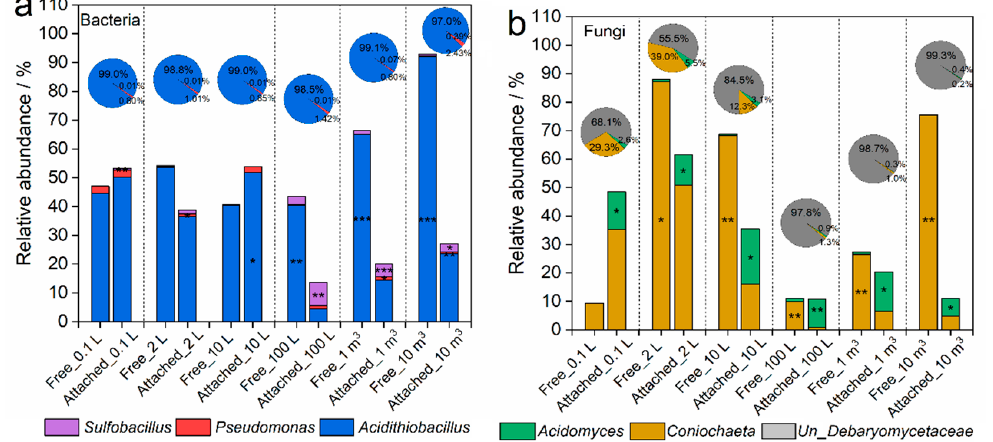
Figure 2. Relative abundance of dominant genera in free and attached microbial communities: ( a ) bacteria; ( b ) fungi. The pie charts represent the initial microbial community structures of mixotrophic acidophiles in different scale-up cultivation stages. Asterisks indicate the significantly higher means analyzed by pairwise t -test, * p < 0.05, ** p < 0.01, *** p < 0.001.